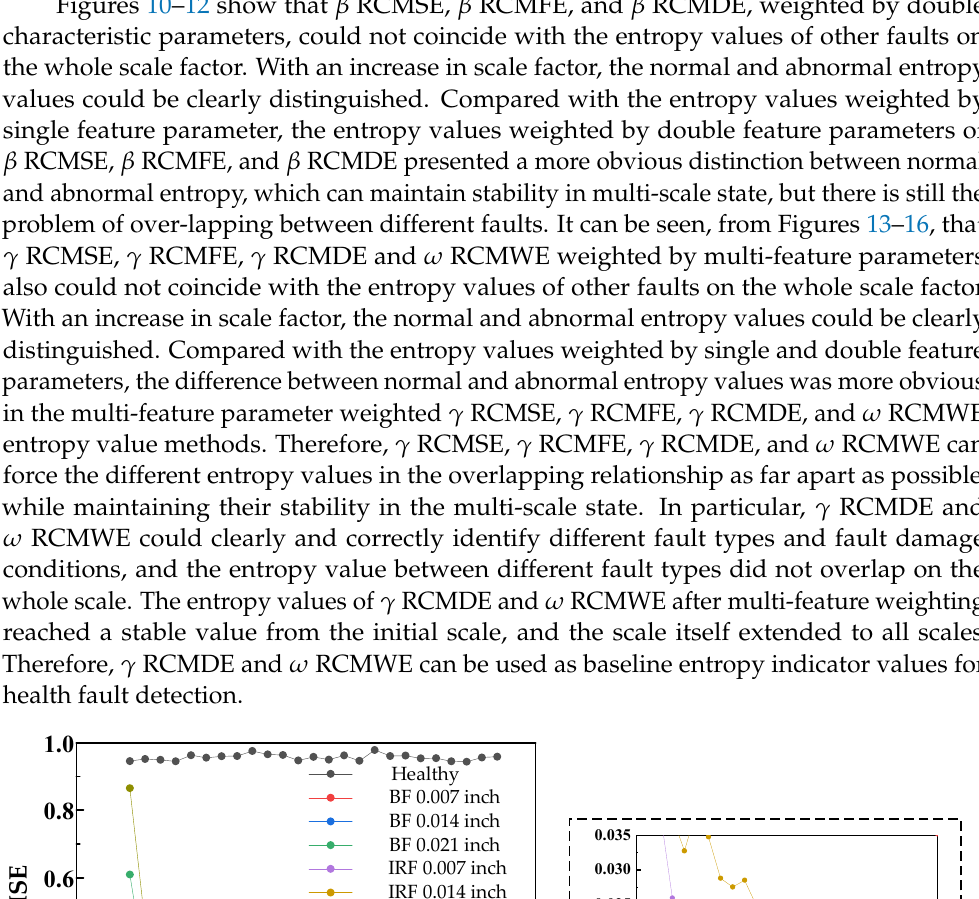
Figure 12. β RCMDE entropy values of 25 scale factors under different damage degrees.